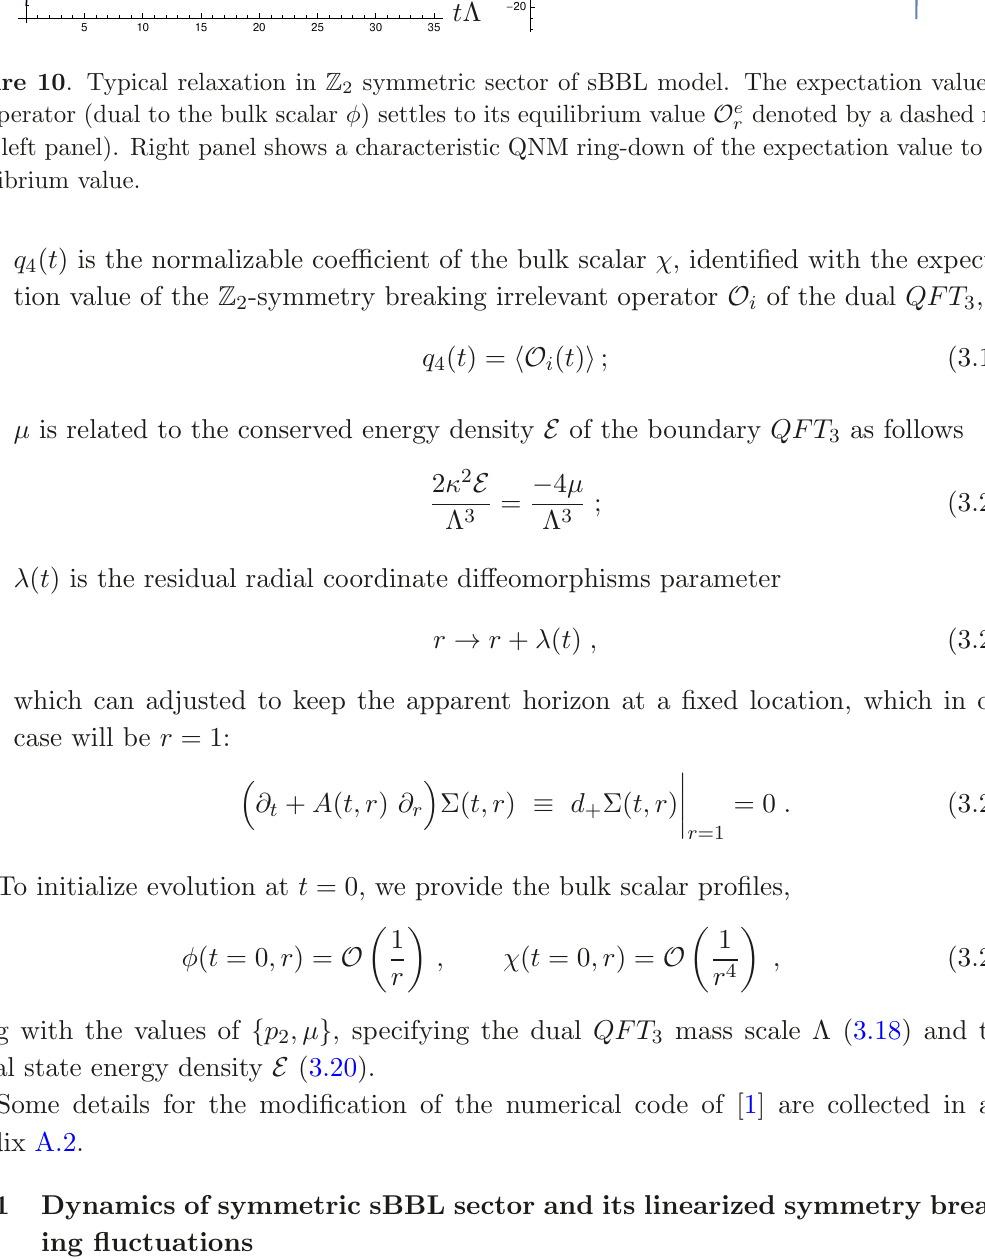
e denoted by a dashed red r O